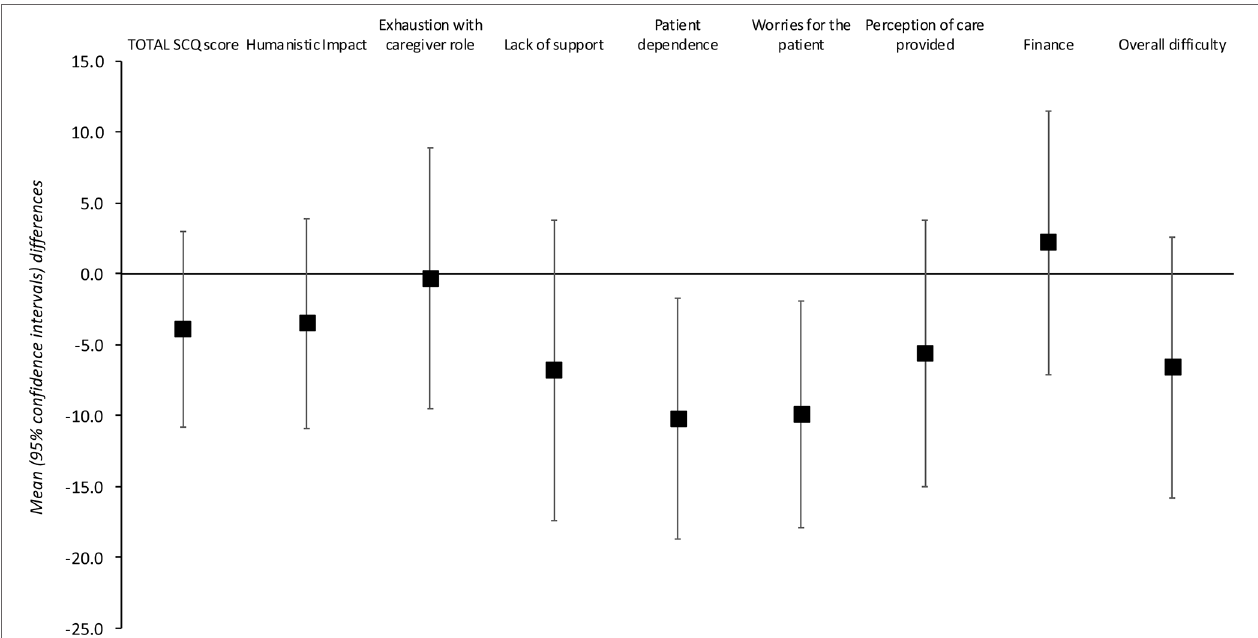
FIGURE 1 | Schizophrenia Caregiver Questionnaire total and individual item scores.